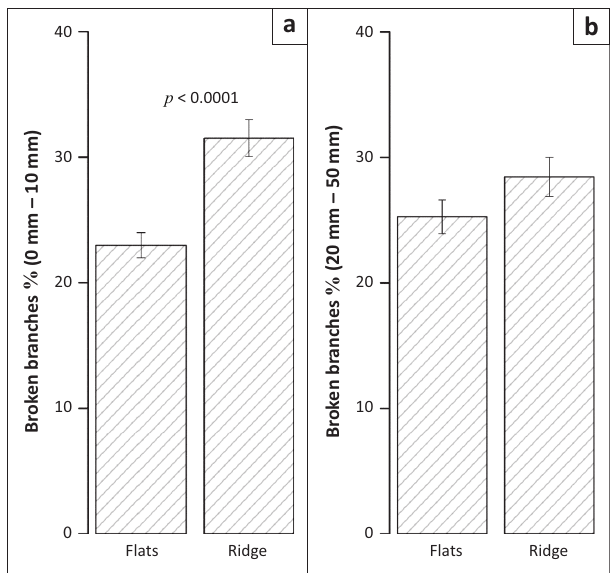
FIGURE 6: Mean proportion of broken branches on ridges versus flats for 12 species that were commonly found in both areas: (a) in 0 mm – 10 mm branch size class (Wilcoxon Signed-Rank Test; W = 92 622, p < 0.0001) and (b) in in 20 mm – 50 mm branch size class (Wilcoxon Signed-Rank Test; W = 41 824, p =